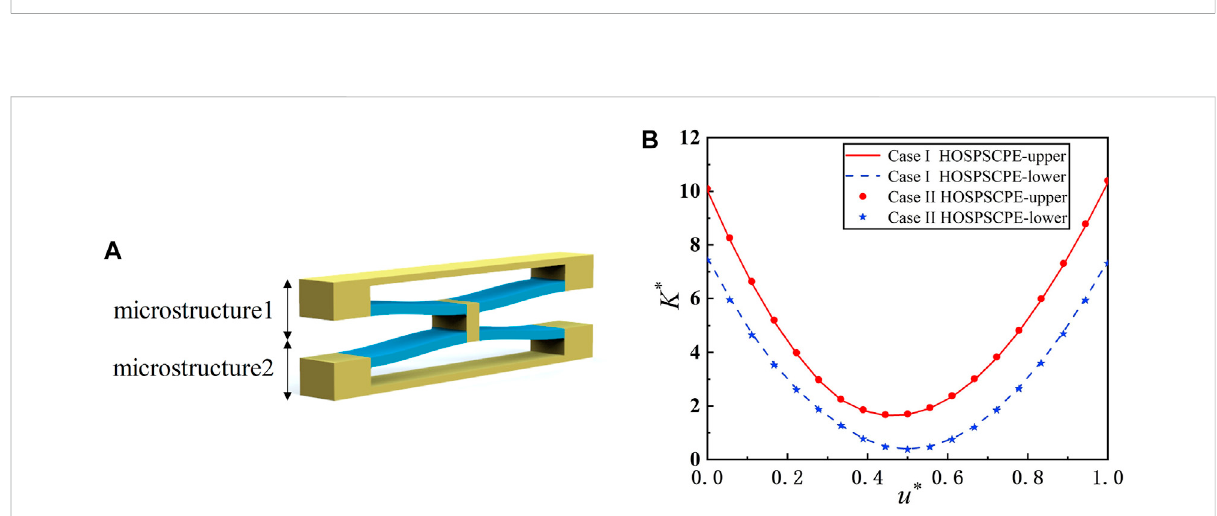
TABLE 4 The interval ranges of geometric parameters under the actual accuracy (0.1 mm) of the 3D printer. Geometric parameter (mm) Accuracy (mm)